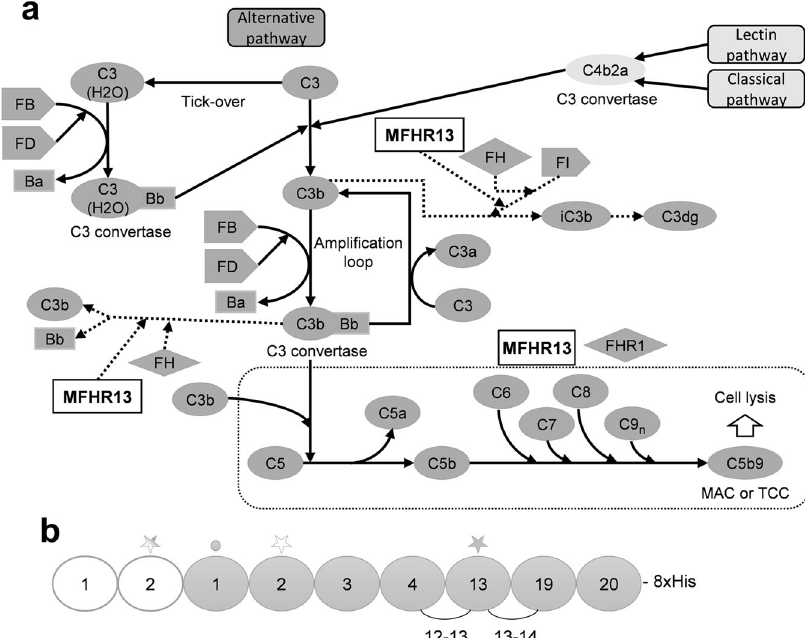
Fig. 1 Schematic representation of complement activation and ampli fi cation by the alternative pathway (AP) and the mechanism of action of MFHR13. a MFHR13 is a regulator of the AP activation at the level of C3 and C5. The complement is activated by three pathways which converge in the formation of C3 convertases and lead to the assembly of C5b-9, called membrane attack complex (MAC), able to induce lysis and cell death. The AP is activated by spontaneous hydrolysis of C3 and acts as an ampli fi cation loop for the cleavage of C3, even when complement was activated by the classical or lectin pathways. Dotted lines and box represent sites of downregulation of AP including the sites where MFHR13 act as regulator in the cascade. b MFHR13 consists of SCRs FHR1 1-2 (white) and 7 SCRs of FH (gray) fused by natural linkers. The gray and white stars indicate glycosylation sites and a deamidated glycosylation site, respectively. The gray dot indicates the position of the polymorphism